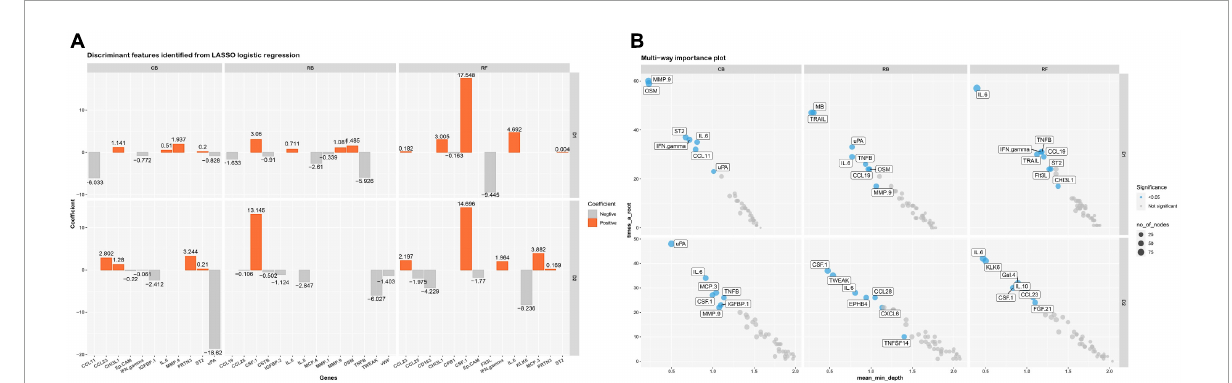
FIGURE6 LASSO logistic regression and random forest of altered proteins in three ablation groups. (A) Significant proteins selected by LASSO logistic regression before and after ablation D1 and D2 in three ablation groups; (B) significant proteins selected by random forest before and after ablation D1 and D2 in three ablation